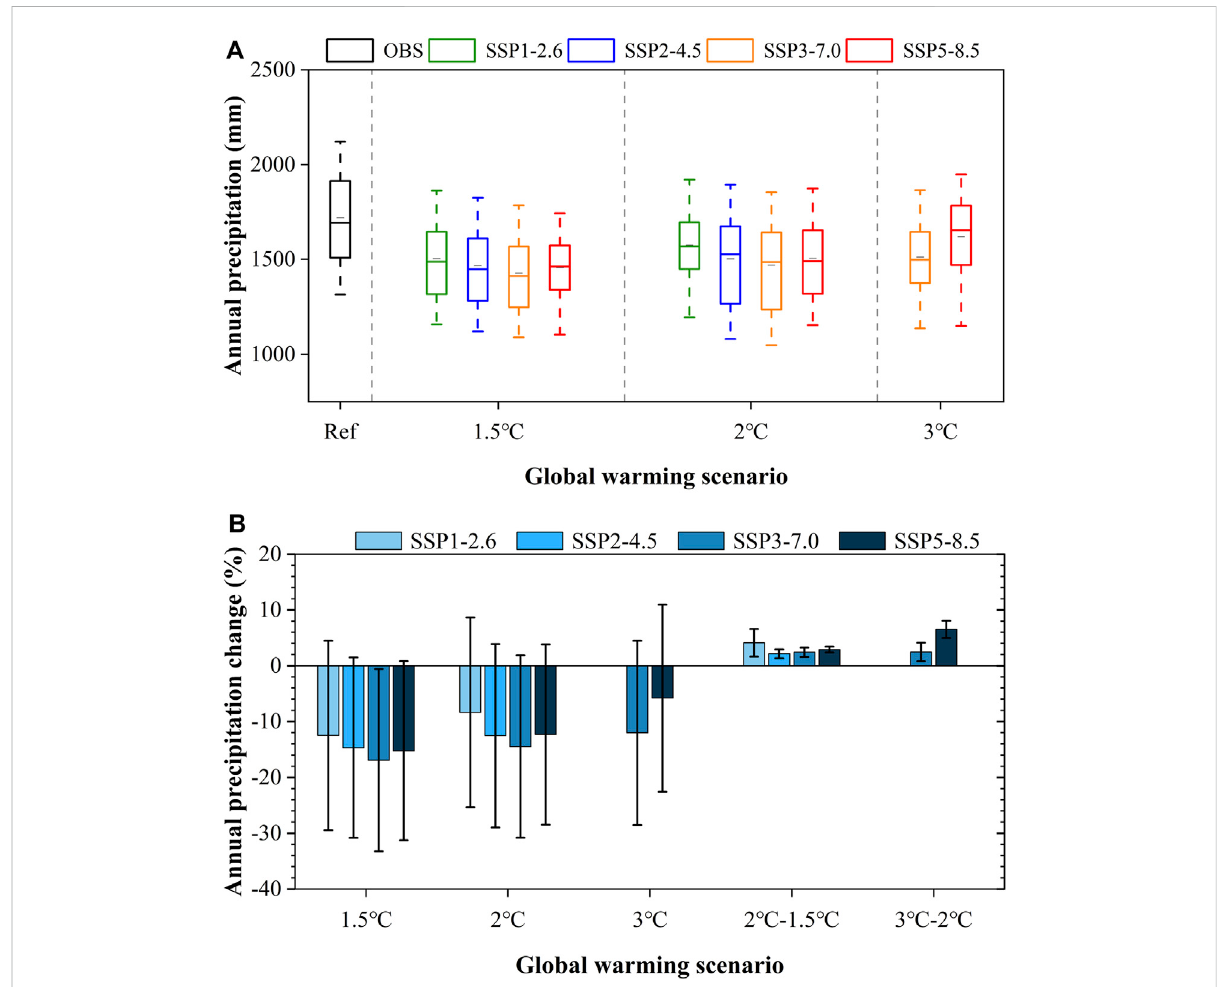
FIGURE 5 Boxplot diagram of precipitation change under different scenarios (A) and the error bar plot of precipitation change relative to the reference period (B) in the PLB. Ref denotes the reference period (1986 – 2005). The black vertical line indicates the standard deviation of 17 CMIP6